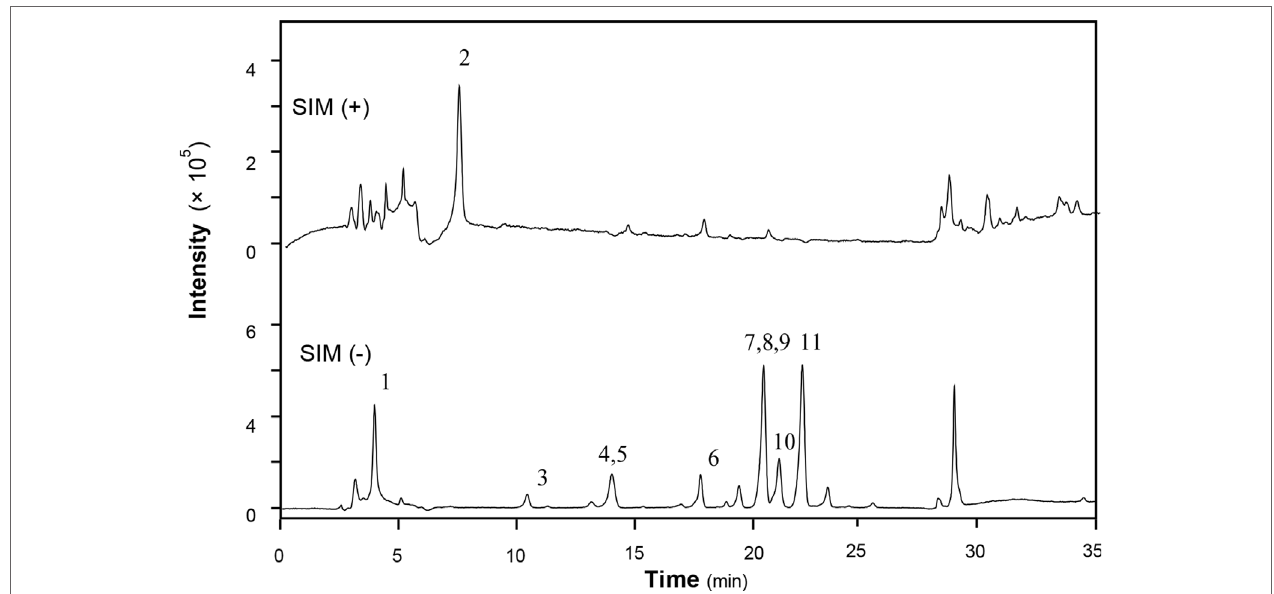
FIGURE 1 | HPLC-MS chromatogram of XEASD extract. A representative LC-MS chromatogram from three batches of XEASD extract is shown. Eight chemical markers were identified in the XEASD extract. The denotation peaks 1–13 were caffeic acid (1), morroniside (2), loganin (3), liquiritin (4), tenuifolin (5), calycosin-